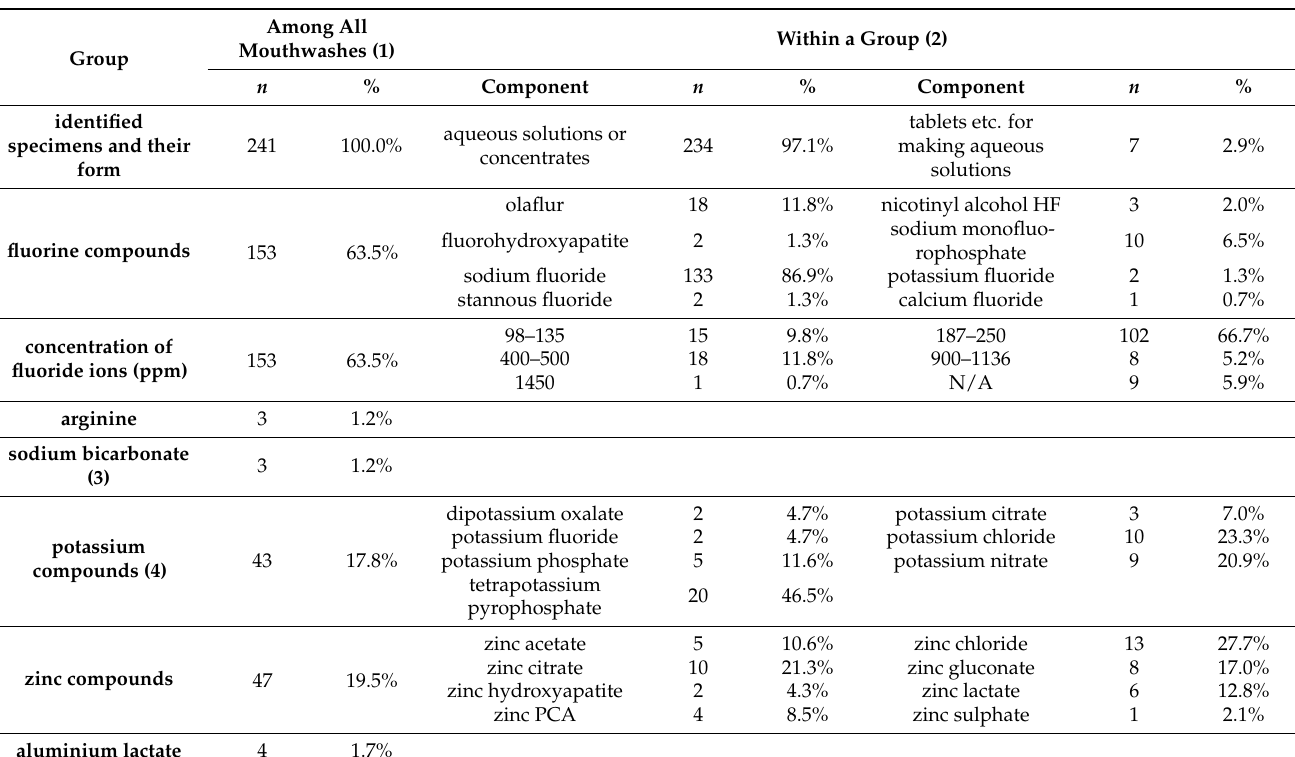
Table 2. Analysis of selected mouthwash